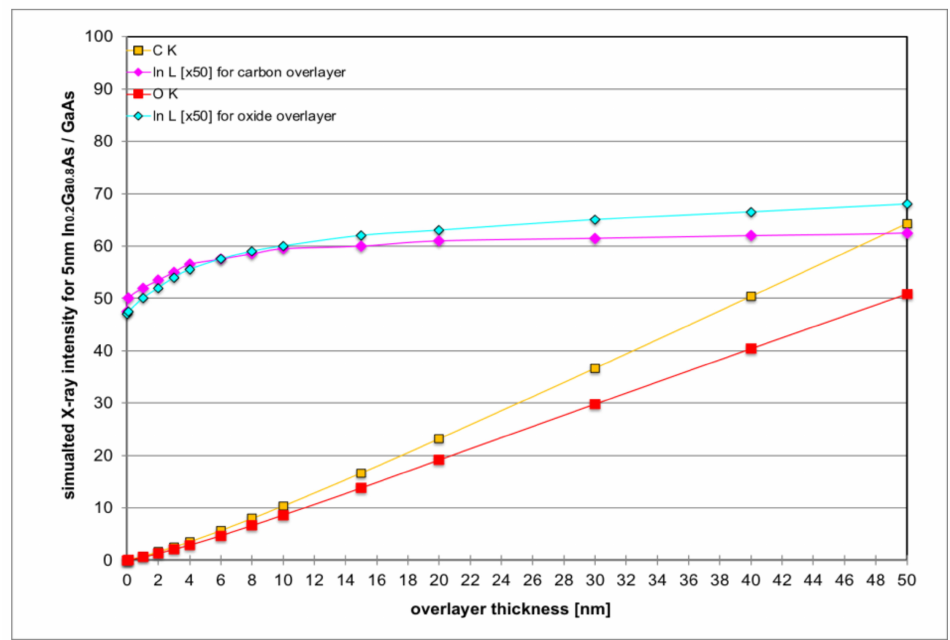
Figure 5. Monte Carlo simulation of the intensities of selected X-ray lines for 5 nm In 0.2 Ga 0.8 As on GaAs as function of overlayer thickness where the surface overlayers are modelled as pure carbon (amber squares for C K, purple diamonds for In L-line, × 50) or pure b-Ga 2 O 3 (red squares for O K-line, turquoise diamonds for In L-line, ×